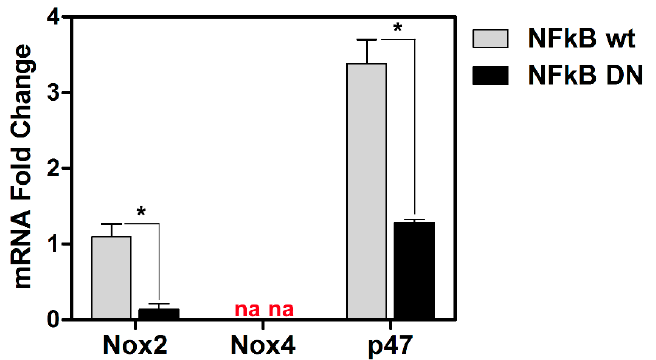
Figure 3. Effects of NF-kB ablation on basal expression of the indicated “oxidant” genes. mRNA levels of Nox2 and Nox4 isoforms and p47 Nox complex component, quantified by qPCR in wt or NFkB DN U937 cells. Data were normalized to 18S rRNA and results are expressed as relative fold change versus Nox2 mRNA levels in wt control cells. Mean values + S.D. from three independent experiments performed in duplicates are depicted. * p < 0.001. na: no amplified cDNA detected.